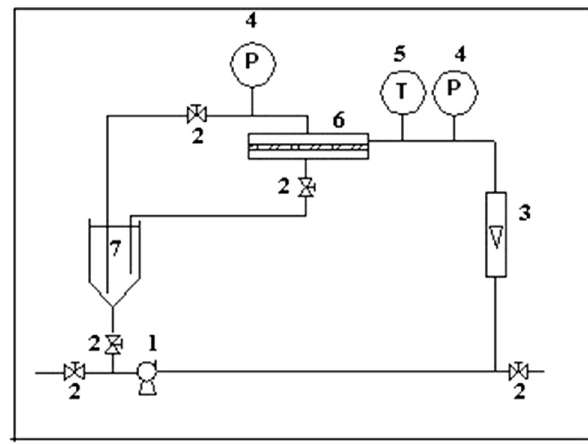
Fig. 3 SEM image of the sample which was sintered at a temperature of 1500 °C for 2 h